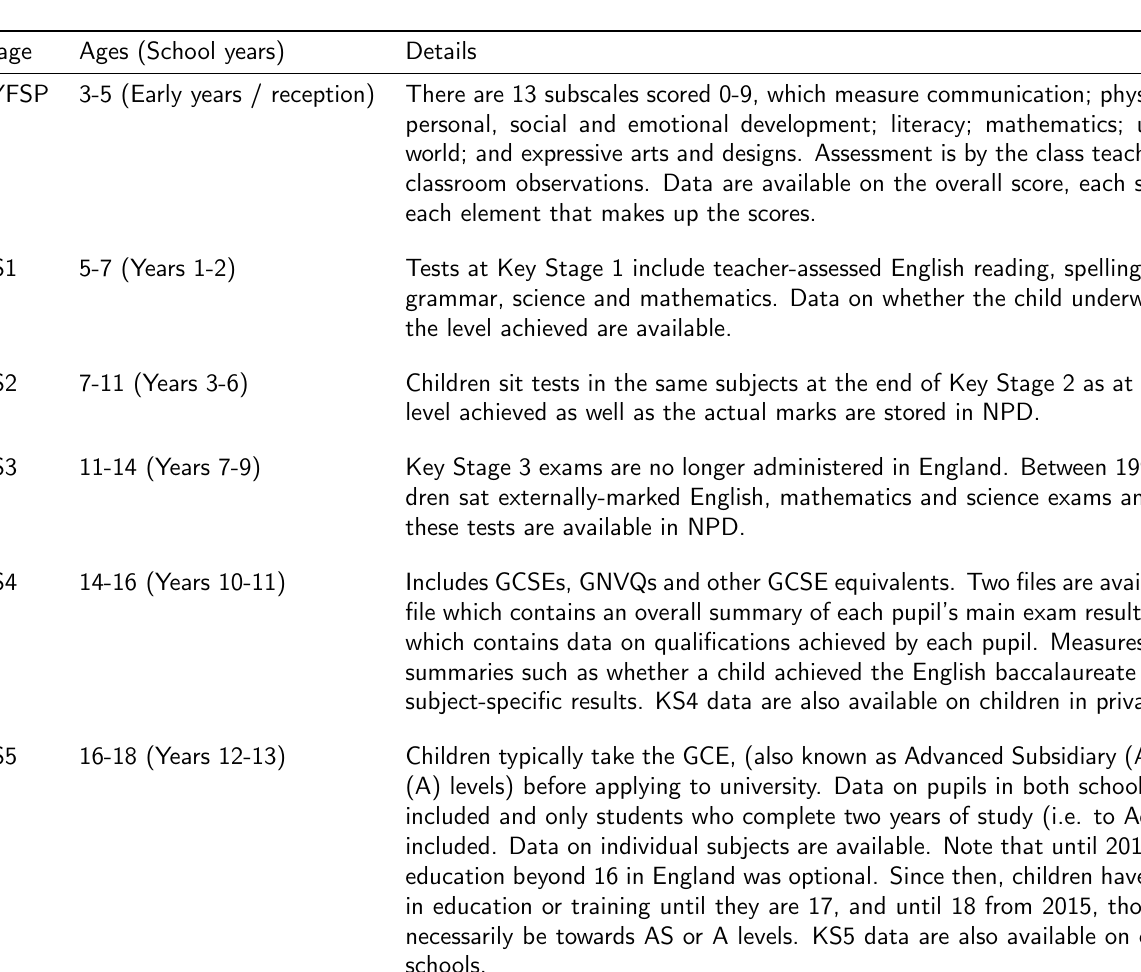
Table 3: Summary of National Pupil Database attainment data